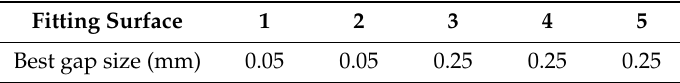
Table 8. Best gap sizes for the chosen possible passageway.